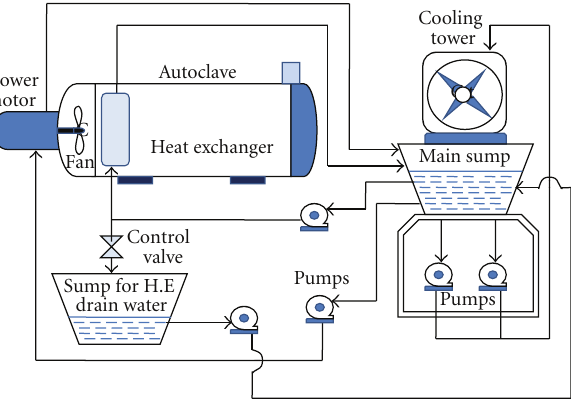
Figure 6: Schematic of cooling system.